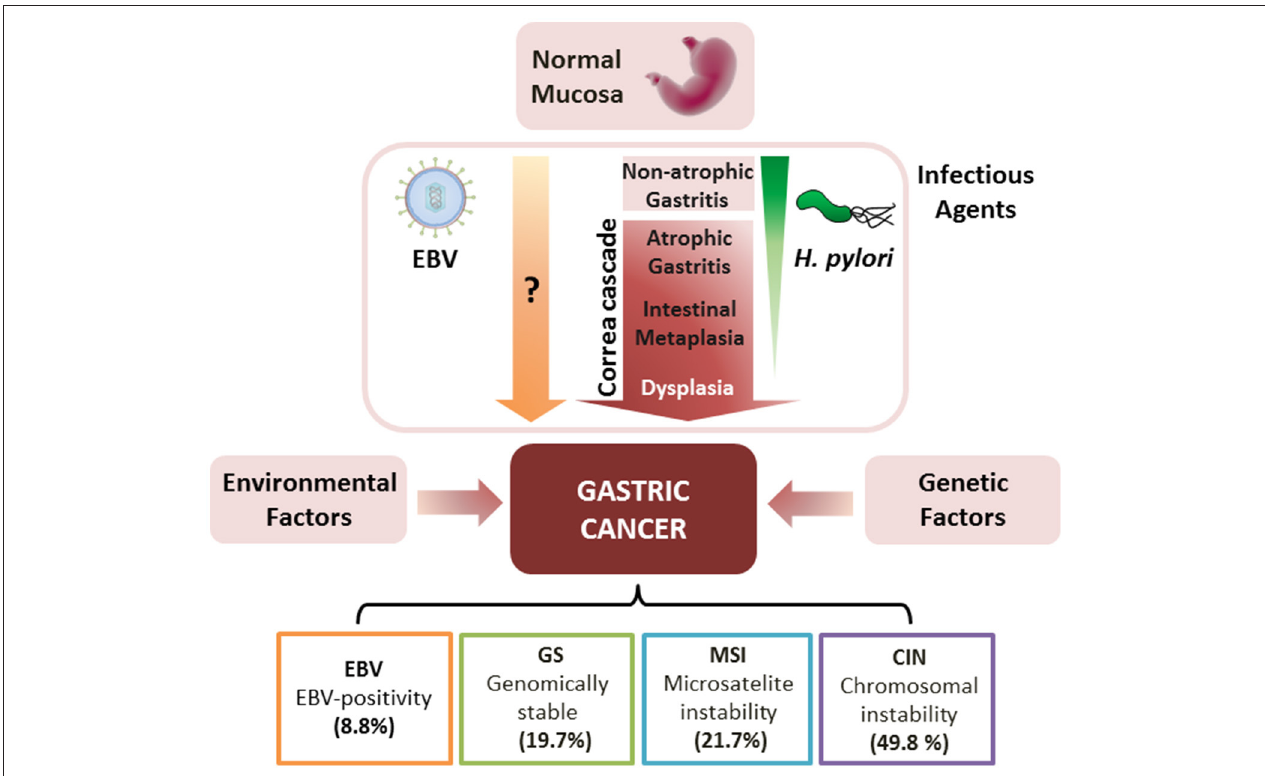
FIGURE 1 | Gastric carcinogenesis, in context of chronic infection ( H. pylori and EBV), and TCGA classification of gastric cancer. H. pylori colonizes normal mucosa inducing non-atrophic gastritis and the precancerous “Correa Cascade,” consisting of multifocal atrophic gastritis, intestinal metaplasia and dysplasia. H. pylori is usually lost during the progression of these lesions (fading green triangle). This process can be complemented by host-dependent genetic and environmental factors leading to gastric cancer. Alternatively, EBV can lead to the development of gastric cancer in an unknown manner. According to TCGA, gastric cancer tumors can be classified by (i) EBV-positivity (EBV), (ii) genomically stable (GC), (iii) microsatellite instability (MSI), and (iv) chromosomal instability (CIN). Percentage of each subtype is